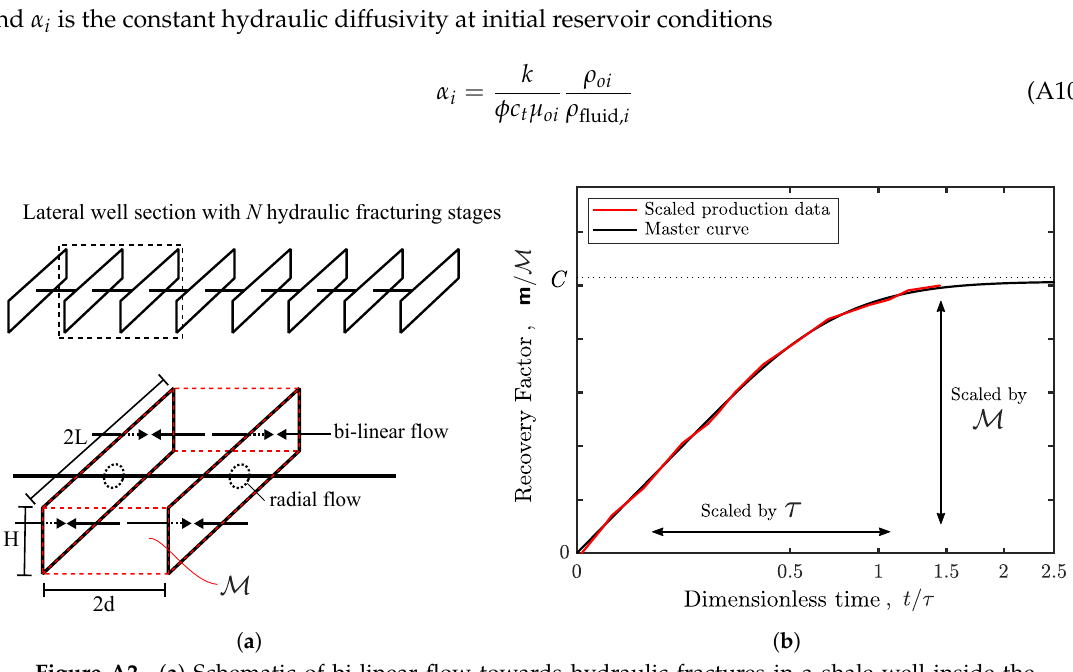
Figure A2. ( a ) Schematic of bi-linear flow towards hydraulic fractures in a shale well inside the SRV with volume H × 2 d × 2 L ( interior problem). The early radial flow is neglected because the hydrofracture permeability is much higher than that of the matrix. Reproduced from Patzek et al. [25] ( b ) Illustration of physical scaling approach of the interior oil production problem. Reproduced from Saputra et al. [27]